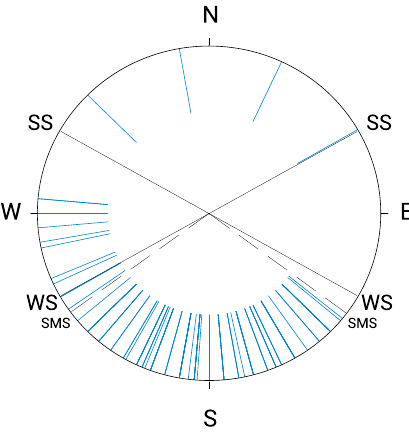
Figure 4. Kernel distribution of the azimuths of Kofun access corridors. The dashed lines indicate the azimuths of the rising/setting of the Sun at the winter solstice (red lines) and of the Moon at the major southern standstill (black lines).